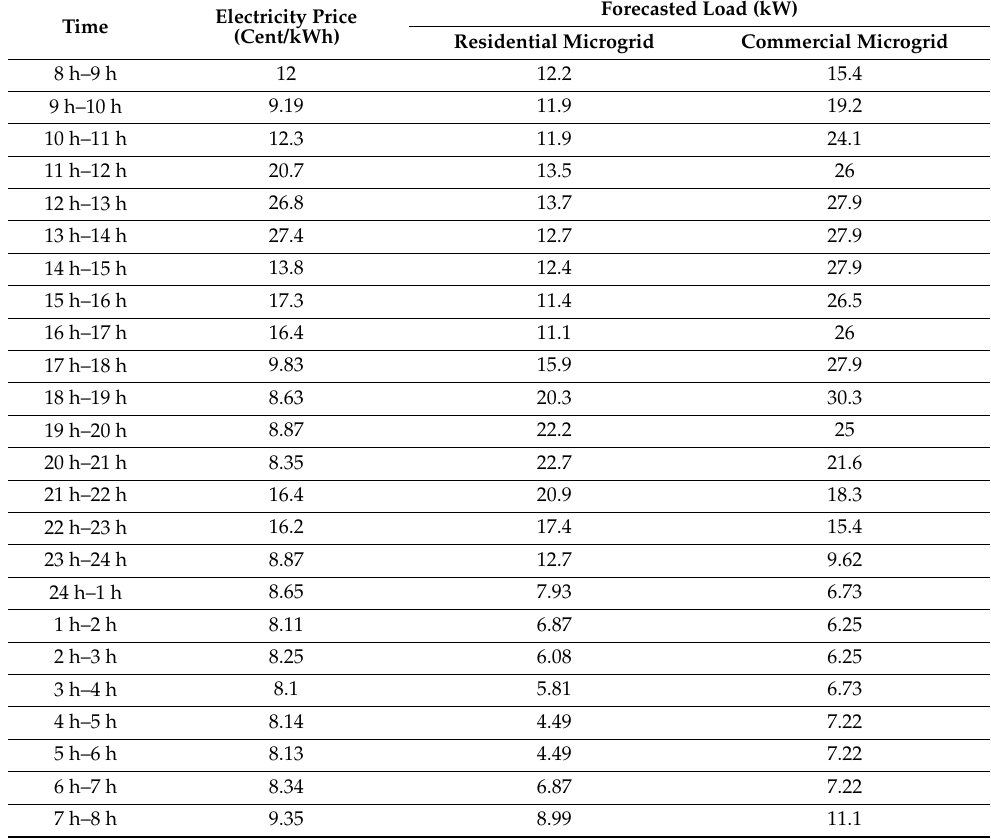
Table 1. Energy prices and forecasted loads [ ? ?